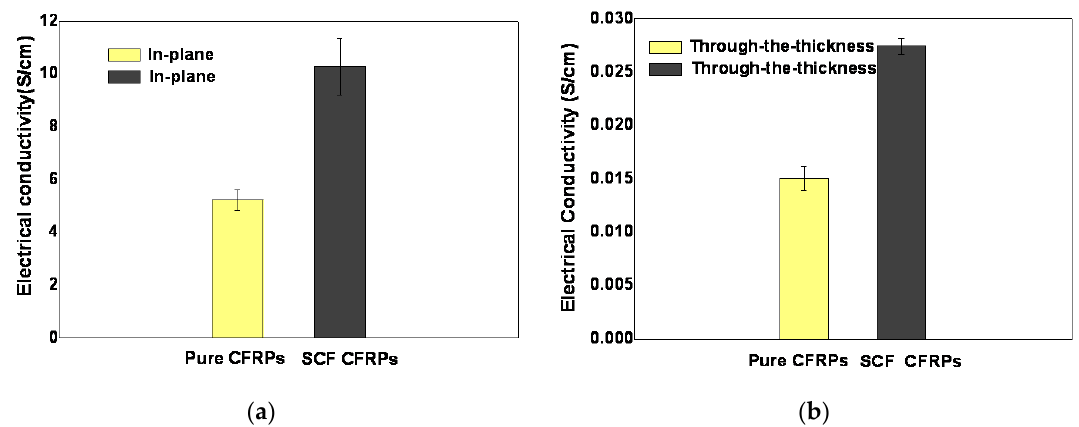
Figure 7. The electrical conductivity of the laminates in different direction ( a ) In-plane; ( b ) Through-the-thickness. Table 3. Increase in electrical conductivity of CFRP composites with various conductive intealeave. Conductivity